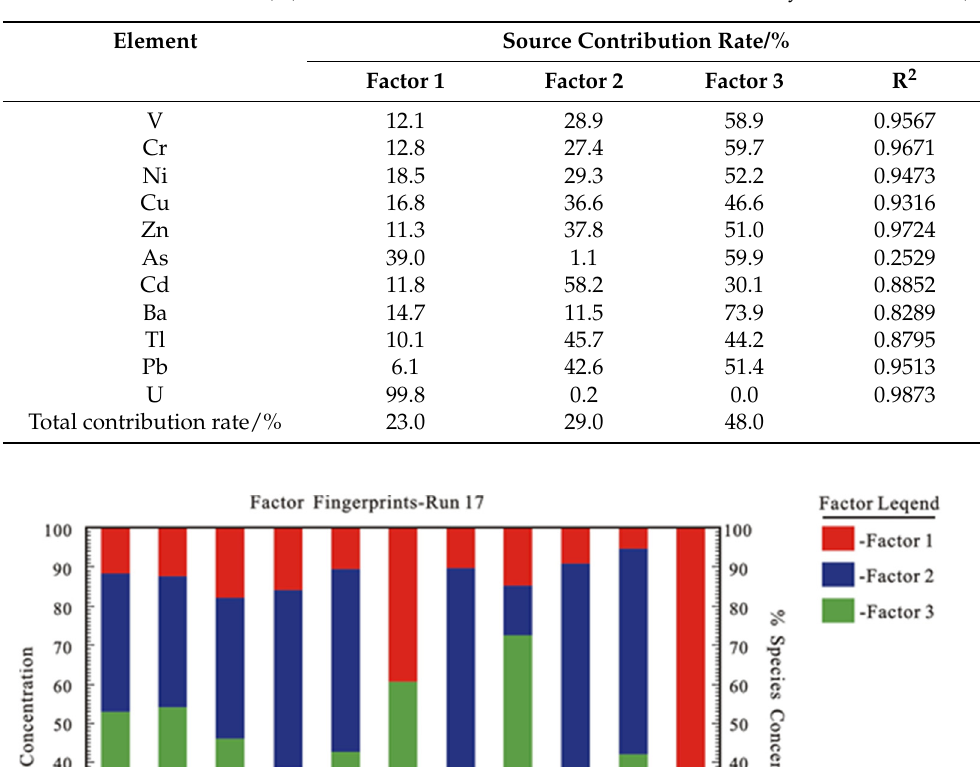
Table 2. Contribution rate (%) results of each factor and element as calculated by the PMF model.).